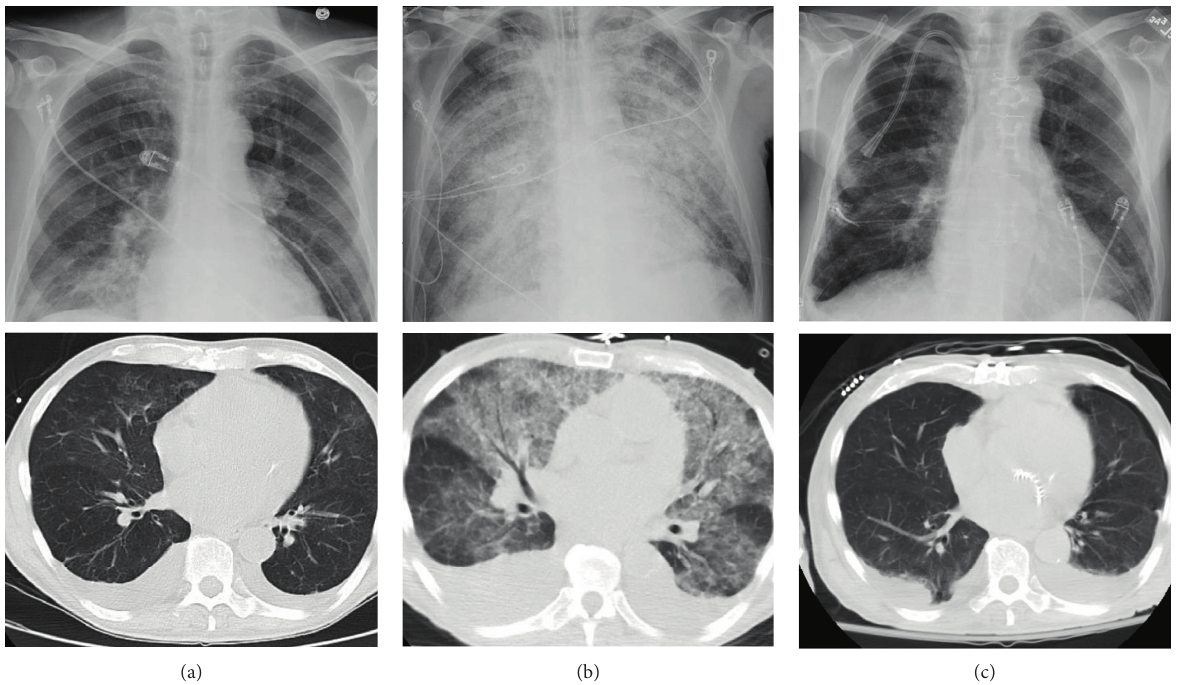
Figure 2: Chest imaging: chest X-ray and chest CTof progression of diffuse alveolar hemorrhage. (a) Day 5 shows right basilar opacity. (b) Day 10 shows diffuse alveolar infiltrates consistent with DAH. (c) Day 15, which was approximately five days postoperation, shows resolution of alveolar